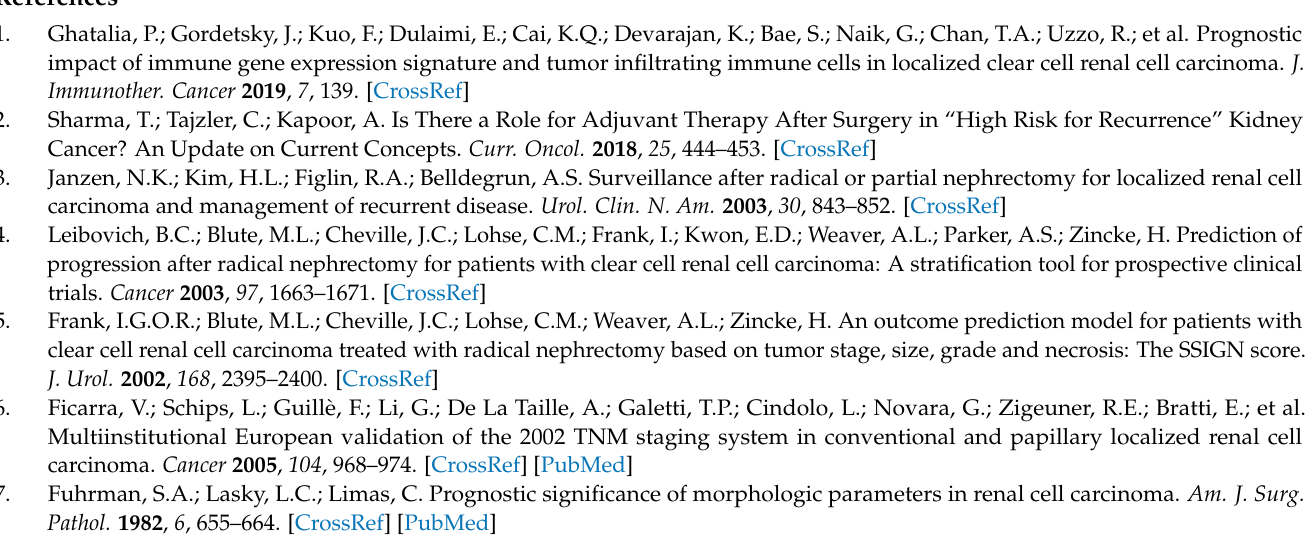
Table S1: Enriched pathways and their target genes from the DEG in the RNAseq